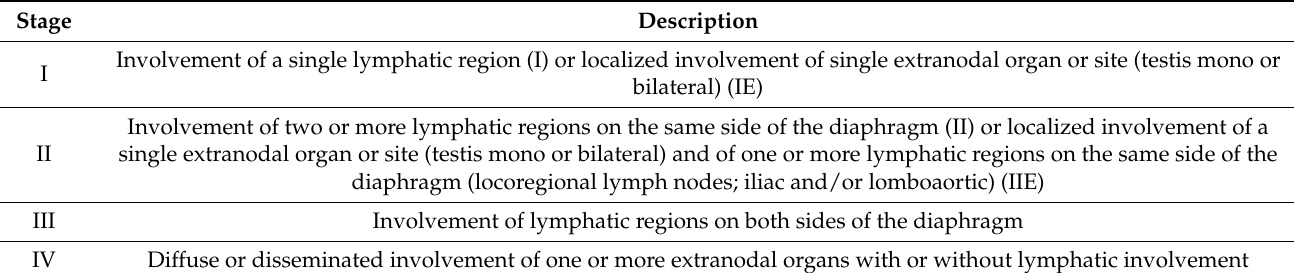
Table 1. Ann Arbor lymphoma stage classification. In T-DLBCL, stage III-IV is defined as advanced stage with mono or bilateral testicular involvement with involvement of distant lymph nodes and/or extranodal sites. Stage Description